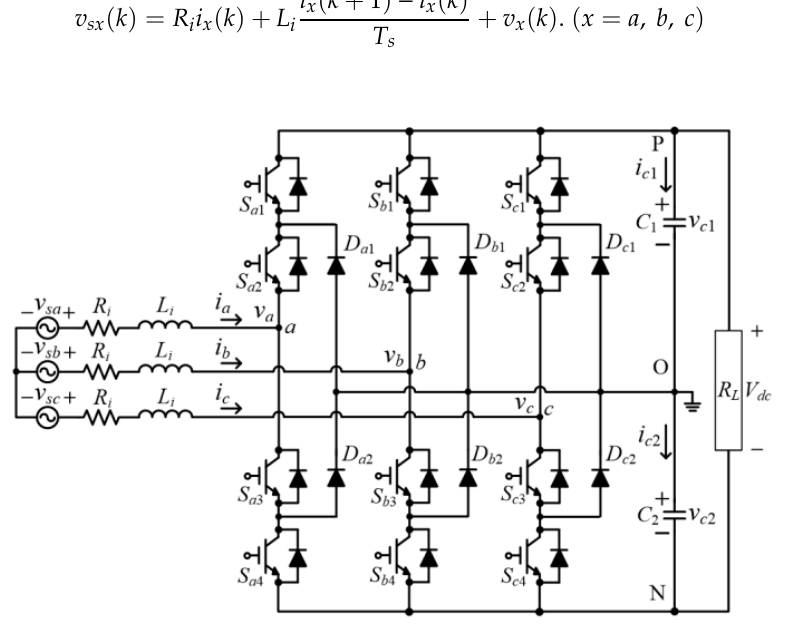
Figure 1. Three-phase three-level NP rectifier.